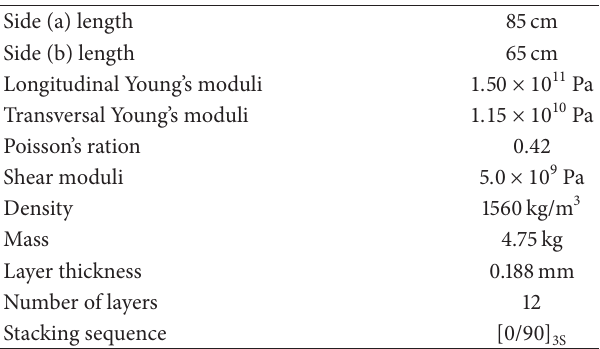
Table 1: Properties of the CFRP